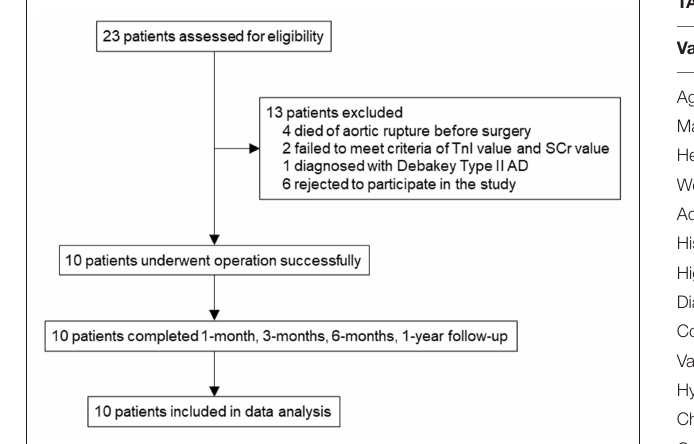
FIGURE 3 | Trial profile. SCr, serum creatine; TnI, troponin I; AD, aortic dissection; CTA, computed tomography angiography; TTE, transthoracic